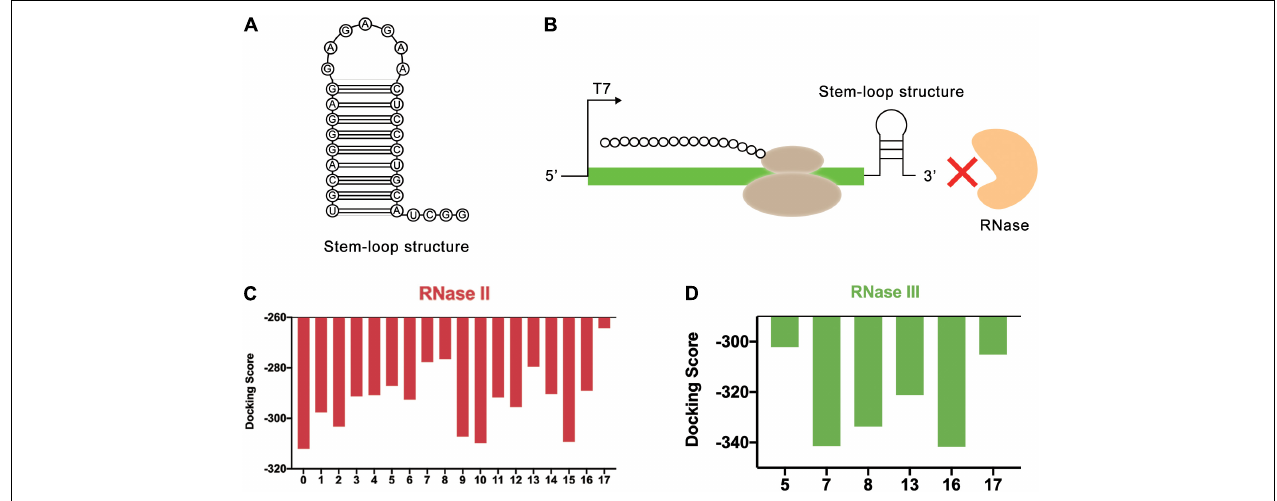
FIGURE 5 | REP sequences could form a stem-loop structure to block the binding of RNase. (A) The secondary structure of stem-loop structure formed by REP sequence. (B) The stem-loop structure could block the end of mRNA. In this way, the REP sequence could protect mRNA from the degradation of RNase. (C) Simulation results of RNase II and REP sequences. The numbers on the abscissa represented different REP sequences, and the number 0 represented the control group without REP sequence. (D) Simulation results of RNase III and REP sequences. The numbers on the abscissa represented different REP sequences.